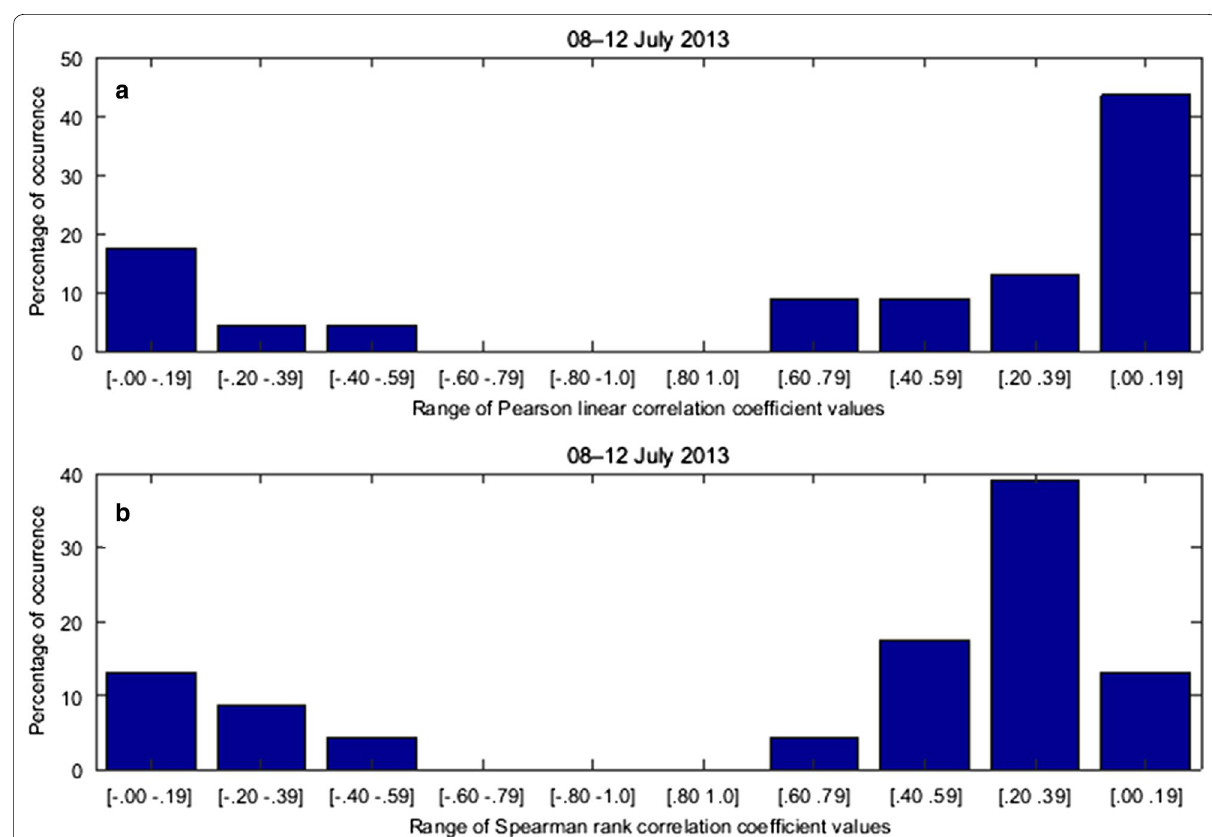
Fig. 5 Percentage of occurrence of different ranges of Pearson linear correlation coefficient ( a ) and Spearman rank correlation coefficient ( b ) computed for all the combined data points in each hour having simultaneous PMSE and particle precipitation in 5-day campaign